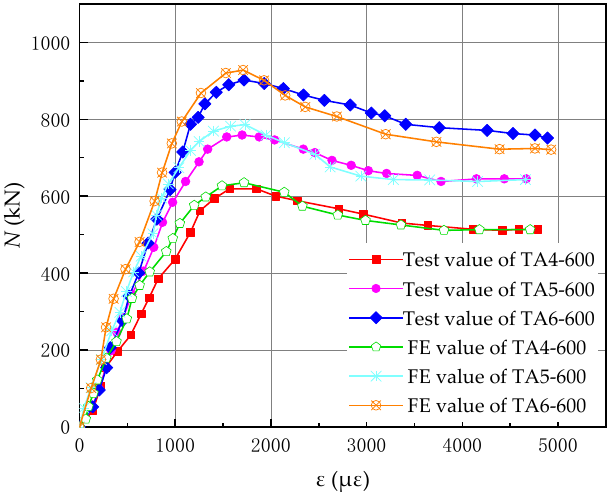
Figure 10. Comparison of the load–strain curves between FE modeling and the test result.